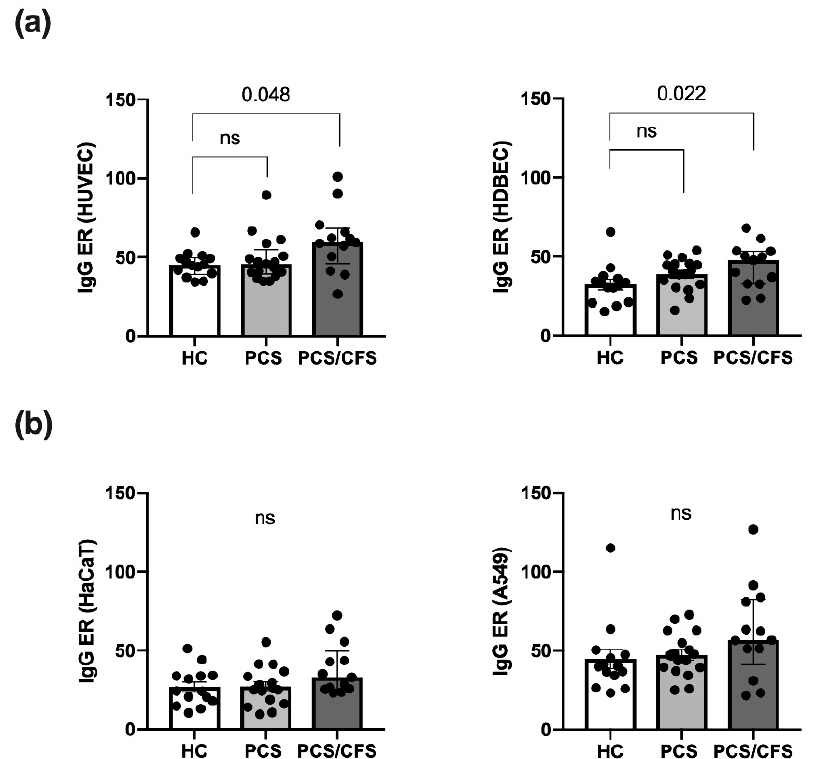
Figure 1. Quantitative analysis of autoantibody binding to cultured human endothelial and non- endothelial cells as determined by cell-based ELISA. Binding of autoantibodies to distinct cultured human cells was evaluated by a cell-based ELISA. Briefly, cells were incubated with 0.5% ( v / v ) patient (PCS, PCS/CFS) or control (HC) serum and an anti-human IgG HRP-labelled secondary antibody was used for detection of bound IgG. Shown are the IgG autoantibody levels as ELISA ratios (ER) normalised to included positive and negative controls for ( a ) two endothelial cell types i.e., macrovascular HUVEC (left) and microvascular HDBEC (right) and ( b ) two non-endothelial control cell lines, i.e., keratinocyte cell line HaCaT (left) and lung epithelial cancer cell line A549 (right). Median, interquartile range and single ER values are plotted. Statistical testing was performed using a Kruska-Wallis test. HC, healthy controls (n = 14). PCS, post-COVID-19 syndrome (n = 17). PCS/CFS, post-COVID-19 syndrome with ME/CFS (n = 13). ns, not significant ( p value > 0.05).